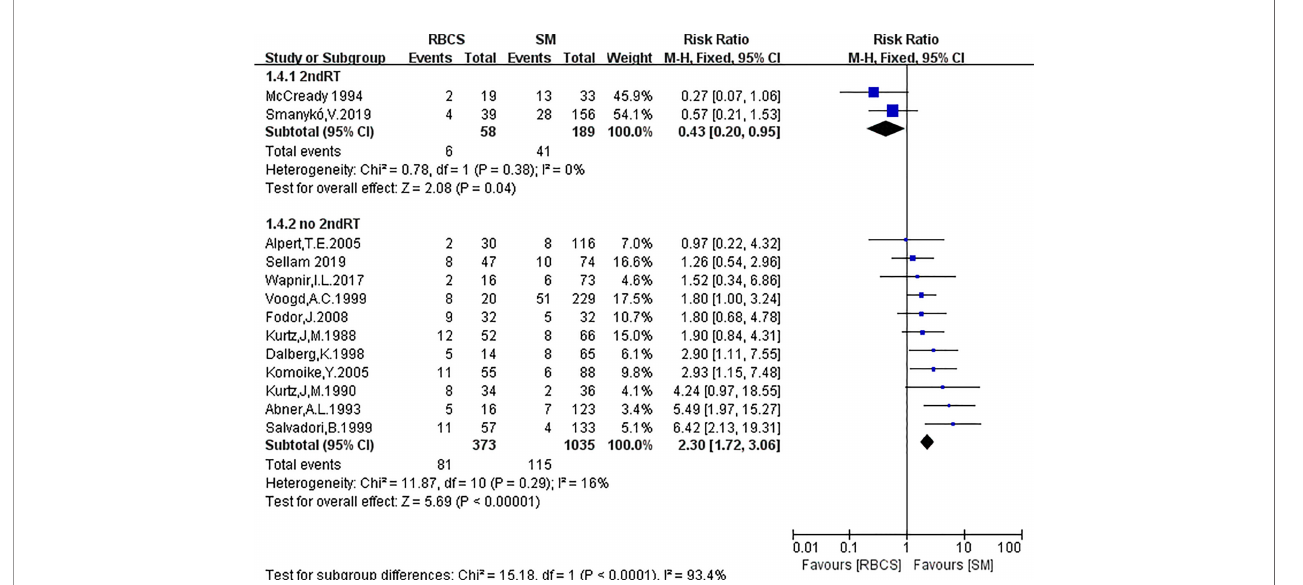
FIGURE 3 | Forest plot of strati fi cation analysis of repeated breast-conserving surgery (RBCS) versus salvage mastectomy (SM) after ipsilateral breast tumor recurrence (IBTR), comparing secondary local recurrence rate (SLRR). The meta-analyse was performed with fi xed-effects model. RR more than 1 means the results favor SM group. 2ndRT: radiotherapy was performed after salvage surgery; no-2ndRT: radiotherapy was not performed after salvage